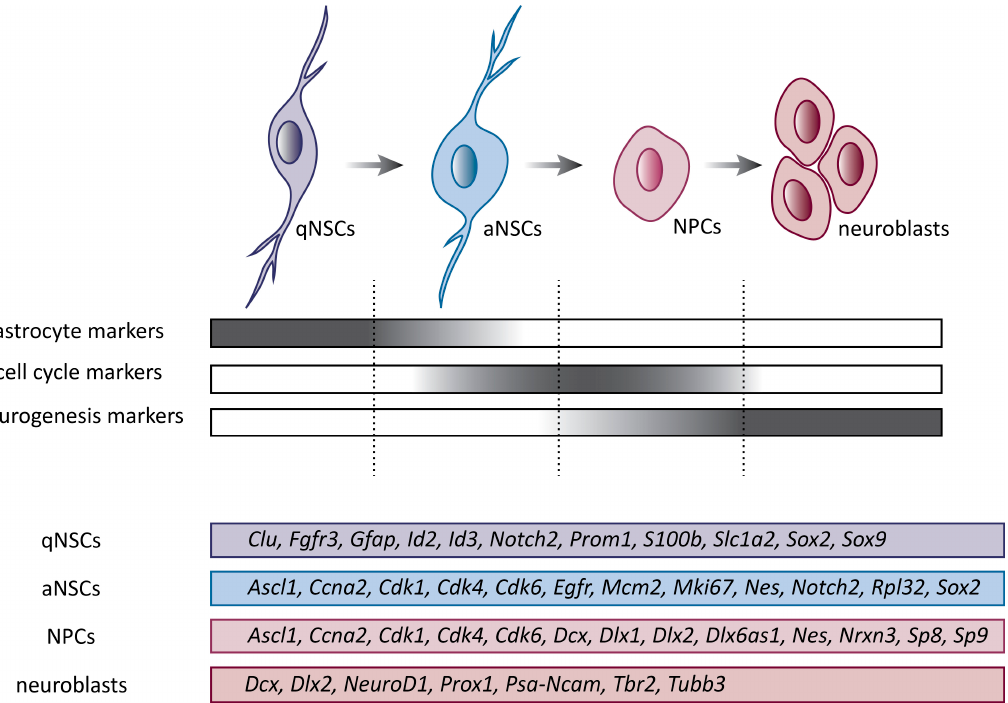
Figure 1. Cell subtypes involved in progression from quiescent neural stem cells (qNSCs) to neuroblasts. Schematic representation of lineage progression. QNSCs give rise to activated neural stem cells (aNSCs), which di ff erentiate into highly proliferative progenitor cells (NPCs) and finally to neuroblasts. Expression of key genes related to particular cell subtypes is depicted. Ascl1 , achaete-scute family bHLH transcription factor 1; Ccna2 , cyclin A2; Cdk1 , cyclin dependent kinase 1; Cdk4 , cyclin dependent kinase 4; Cdk6 , cyclin dependent kinase 6; Clu , clusterin; Dcx, doublecortin; Dlx1 , distal-less homeobox 1; Dlx2 , distal-less homeobox 2; Dlx6as1 , distal-less homeobox 6, opposite strand 1; Egfr , epidermal growth factor receptor; Gfap , glial fibrillary acidic protein; Id2 , inhibitor of DNA binding 2; Id3 , inhibitor of DNA binding 3; Mcm2 , minichromosome maintenance complex component 2; Mki67 , antigen identified by monoclonal antibody Ki-67; Nes , nestin; NeuroD1 , neurogenic di ff erentiation 1; Notch2 , notch 2; Nrxn3 , neurexin 3; Prom1 , prominin-1; Prox1 , prospero homeobox 1; Psa-Ncam , polysialylated neural cell adhesion molecule; Rpl32 , ribosomal protein L32; S100b , S100 protein, beta polypeptide, neural; Slc1a2 , solute carrier family 1 (glial high a ffi nity glutamate transporter), member 2; Sox2 , SRY (sex determining region Y)-box 2; Sox9 , SRY (sex determining region Y)-box 9; Sp8 , trans-acting transcription factor 8; Sp9 , trans-acting transcription factor 9; Tbr2 , eomesodermin; Tubb3 , tubulin, beta 3 class